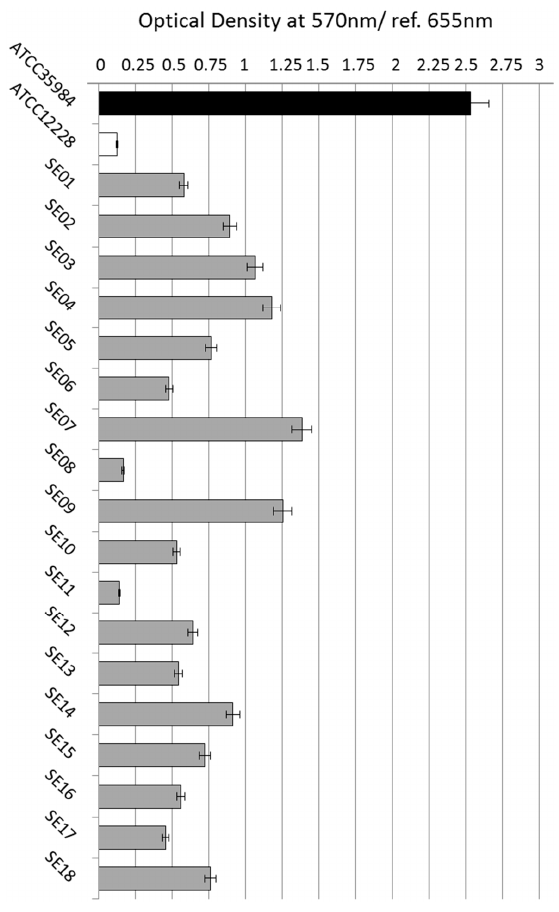
Figure 1. Staphylococcus epidermidis biofilm assessment. Four isolates showed a high-level of biofilm formation (biofilm index ≥ 1) (SE03, SE04, SE07, and SE09); ten moderate biofilm formations (biofilm index ≥ 0.5) (SE01, SE02, SE05, SE10, SE12, SE13, SE14, SE15, SE16, and SE18); two showed a low-level of biofilm formation (biofilm index < 0.5) (SE06 and SE17); and two showed a level overlapped to S. epidermidis ATCC 12,228 non-biofilm producer (SE08 and